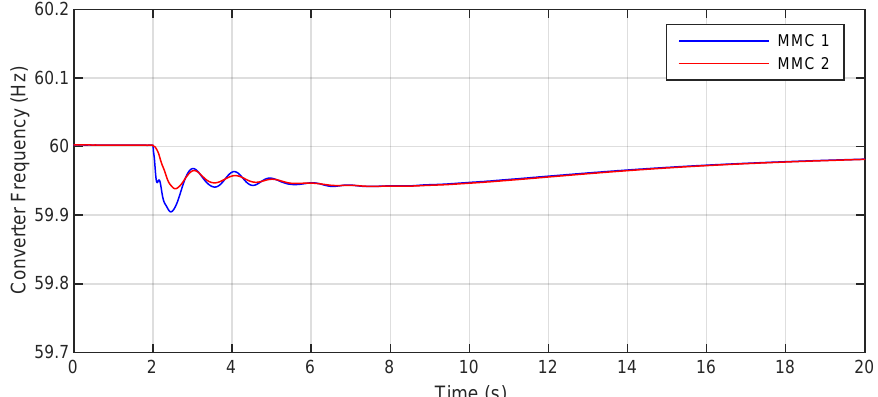
Figure 9. Frequency of the voltage generated at the HVDC converter terminals after the disturbance in Scenario 1.